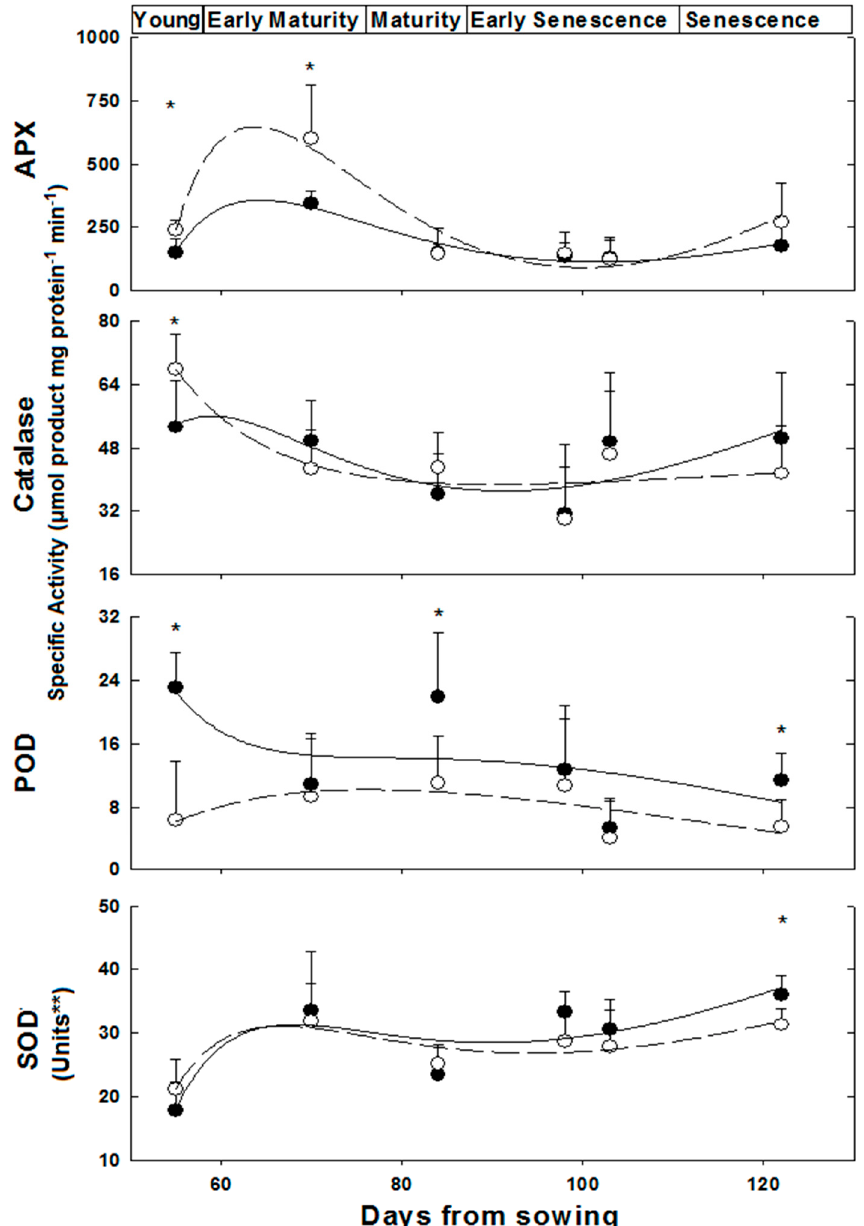
Figure 2. Anti-oxidative enzymes activity in M. annua female and male leaves during development. Plants were grown in soil without salt and at the indicated time points were harvested for analysis as indicated in the Experimental Section. The data was fitted by a 3rd order polynomial curve. Ave ± SD, n = 3. Open circle—female plant; Black circle—male plant. * indicate significant difference ( p < 0.05) between female and male at a given day; ** One unit of SOD activity was defined as the amount of protein required to cause 50% inhibition of NBT